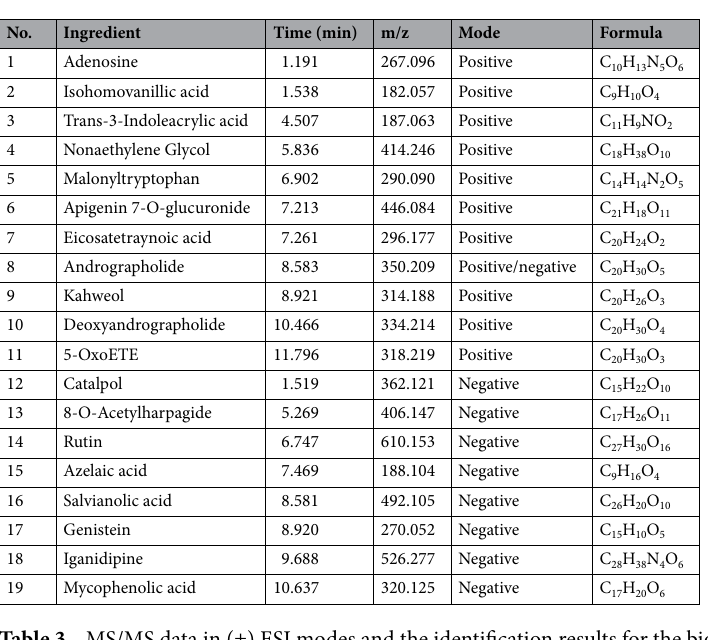
Table 3. MS/MS data in (±) ESI modes and the identification results for the bioactive compounds of the Chuan Xinlian.